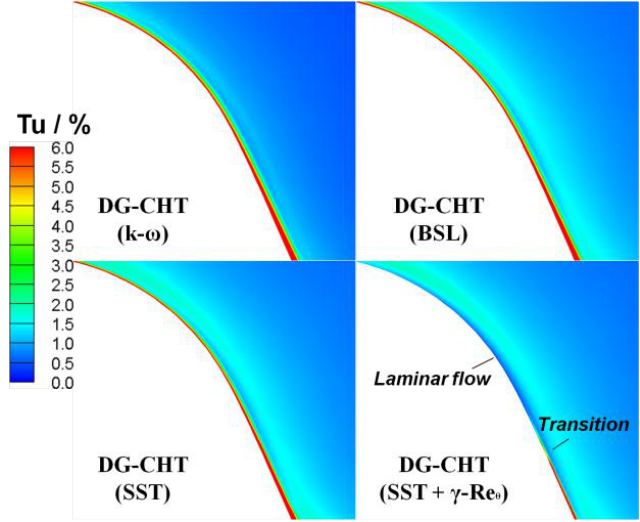
Figure 14. Turbulence intensity contours in the boundary layers above the suction surface around leading edge of the vane.